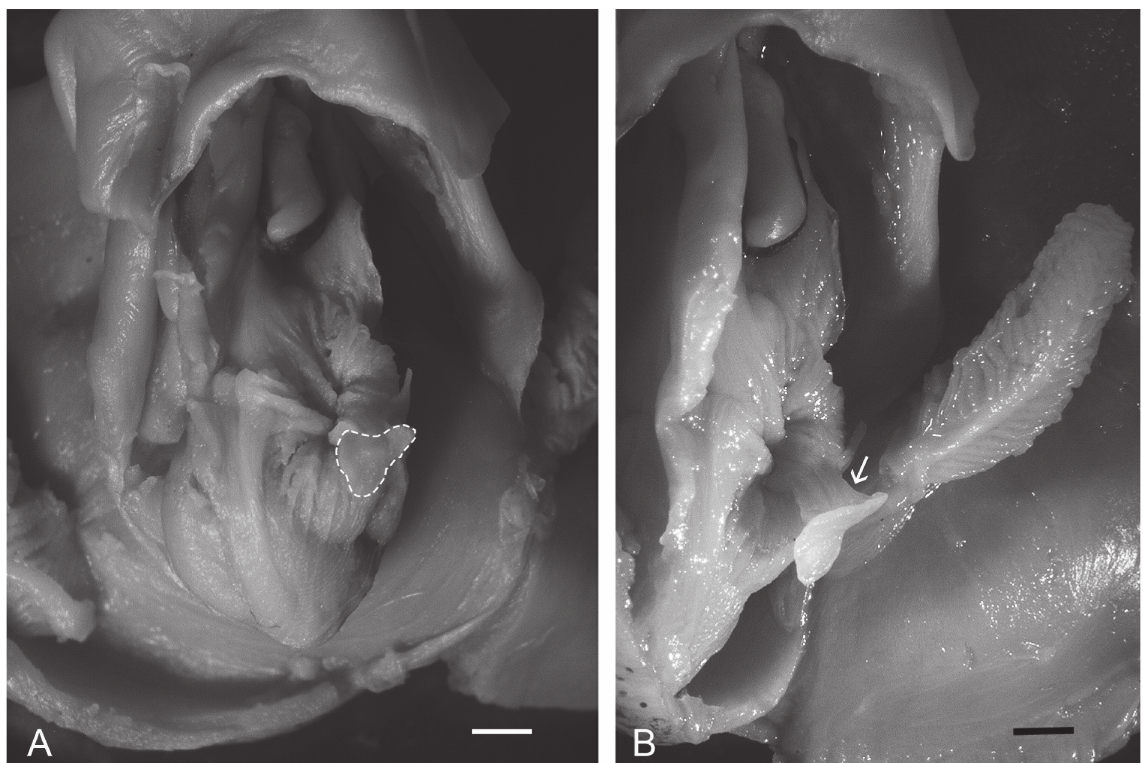
Fig. 7. Bursa copulatrix of Sepiola boletzkyi sp. nov., paratype, ♀, ESFM-CEP/1994-2. A . Ventral view; the dashed line encloses the distal surface of the large fungiform process. B . Oblique ventral view; the fungiform process sticks out of the bursa, laterally to the folds convergence; an arrow points to the longitudinally folded stalk of the process. Scale bar for both figures = 1